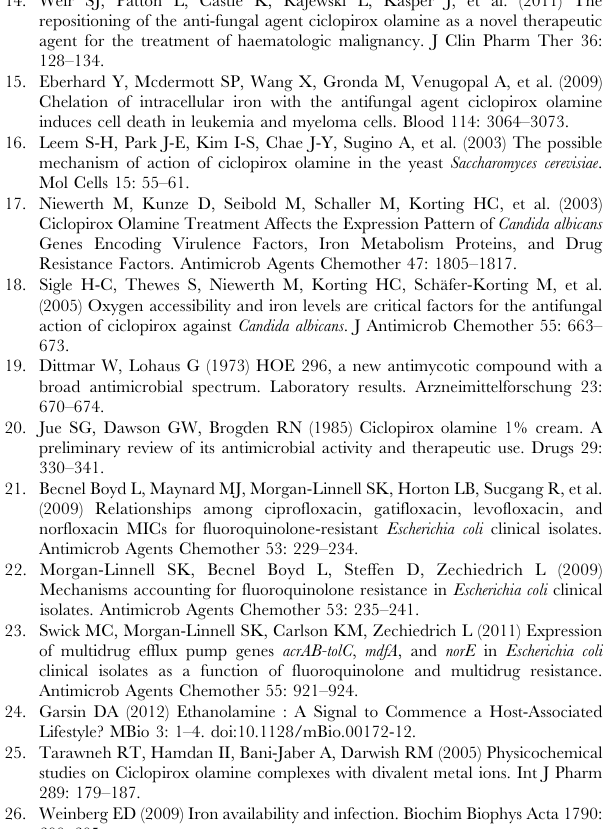
Figure S1 Effect of DMSO on GalE epimerization. (A) Schematic representation of GalE epimerization of UDP-galactose to UDP-glucose coupled to the activity of UDP-glucose dehydro- genase (UGD). (B) Using the assay schematized in A, the average rate of NADH formation with or without DMSO was measured three independent times per DMSO percentage. Error bars are the standard deviation from the mean. Figure S2 Effect of ciclopirox on UDP-glucose dehydro- genase. (A) Schematic representation of UDP-glucose dehydro- genase (UGD) activity converting UDP-glucose into UDP- glucuronic acid. (B) Using the assay schematized in A, the average rate of NADH formation with or without ciclopirox was measured three independent times per ciclopirox percentage. Error bars are the standard deviation from the mean.